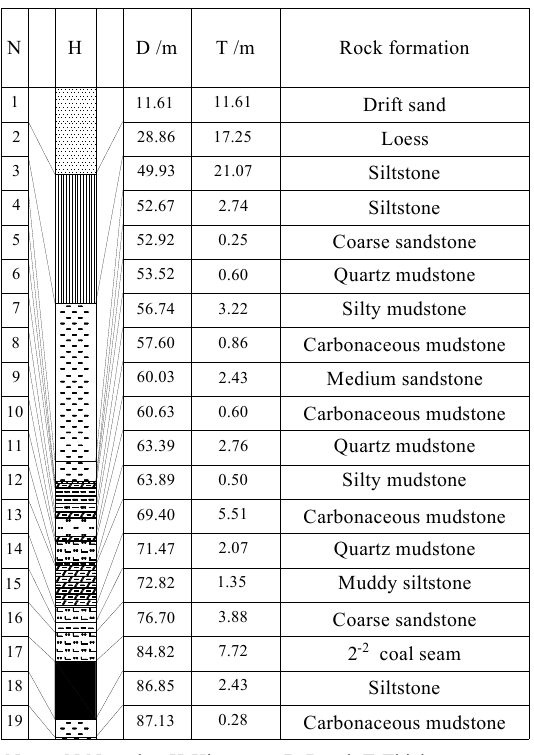
Figure 2. 176# drilling histogram of No. 22201 working face.